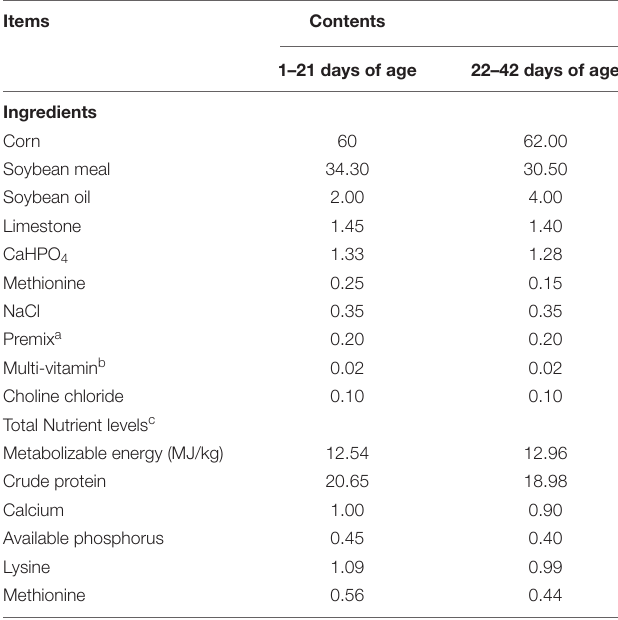
TABLE 1 | Composition and nutrient levels of basal diets (air-dry basis)